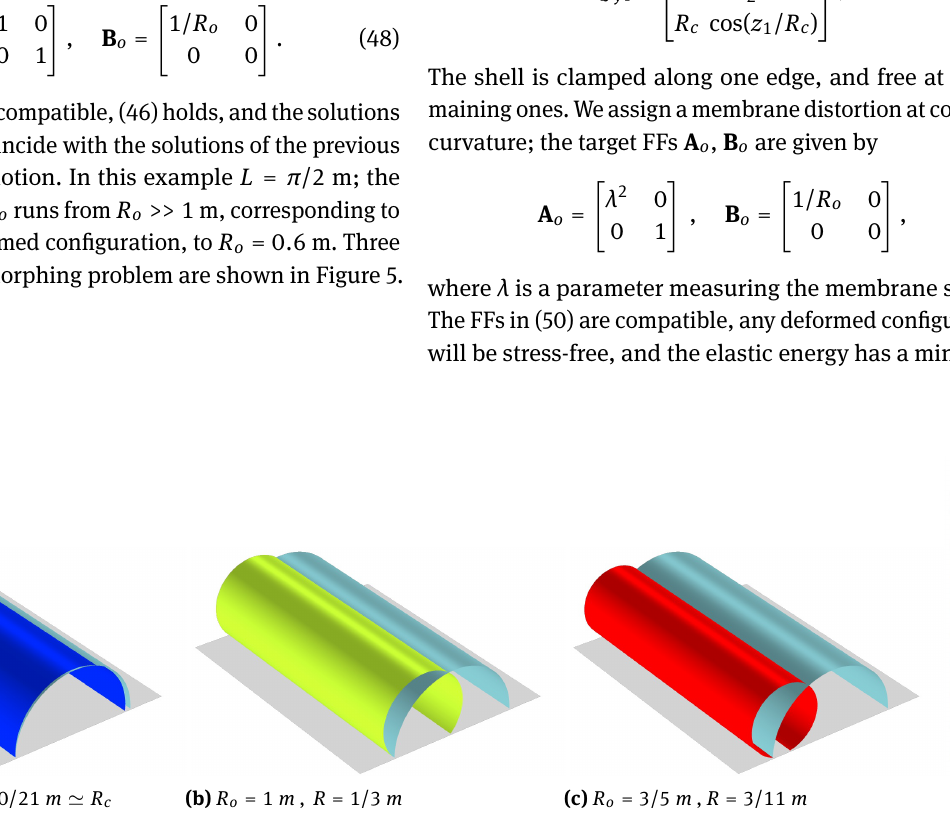
Figure 5: Bending of a cylindrical shell obtained by a change of the target metric B o ; edge at left is pinned, edge at right has a slide. Each of the three figures shows the computational domain (gray), the reference surface (cyan), and the actual shape (color map of curvature). Each deformed configuration is